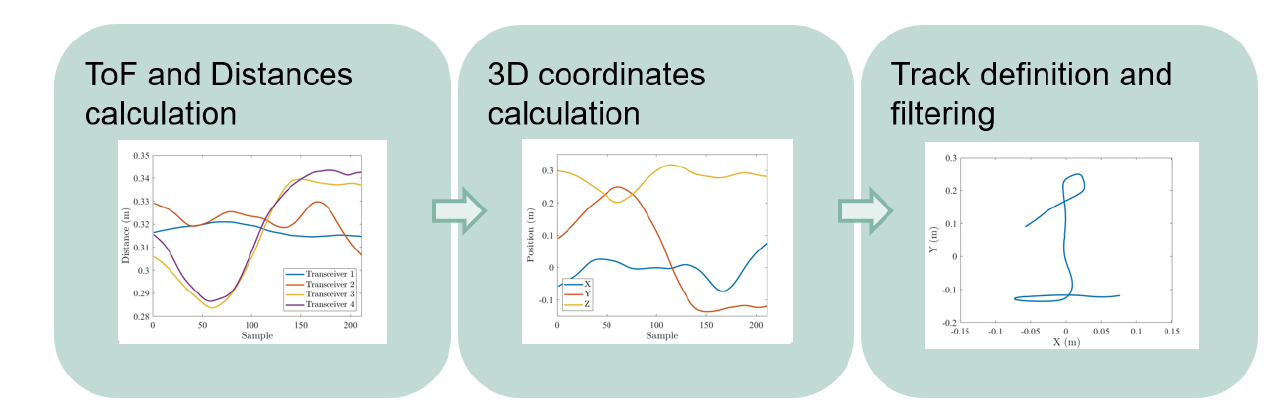
Figure 2. Track generation pipeline.